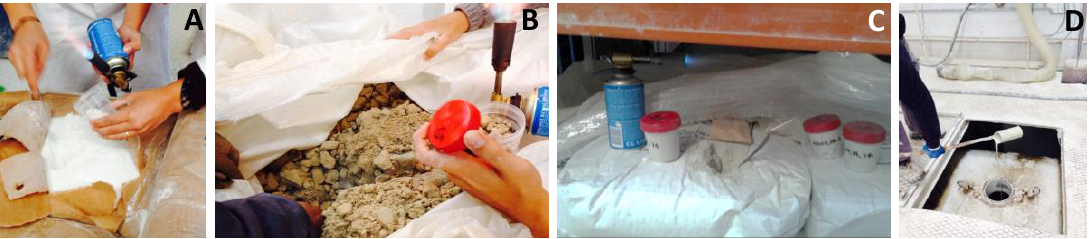
Figure 1. Sampling at Rauschert Portuguesa of ceramic raw materials and slips: ( A ) sampling of talc into sterile containers; ( B ) clay minerals collection from transportation bag; ( C ) replicates collected from each raw material; ( D ) ceramic slip from the mixing tank was collected directly into sterile containers.